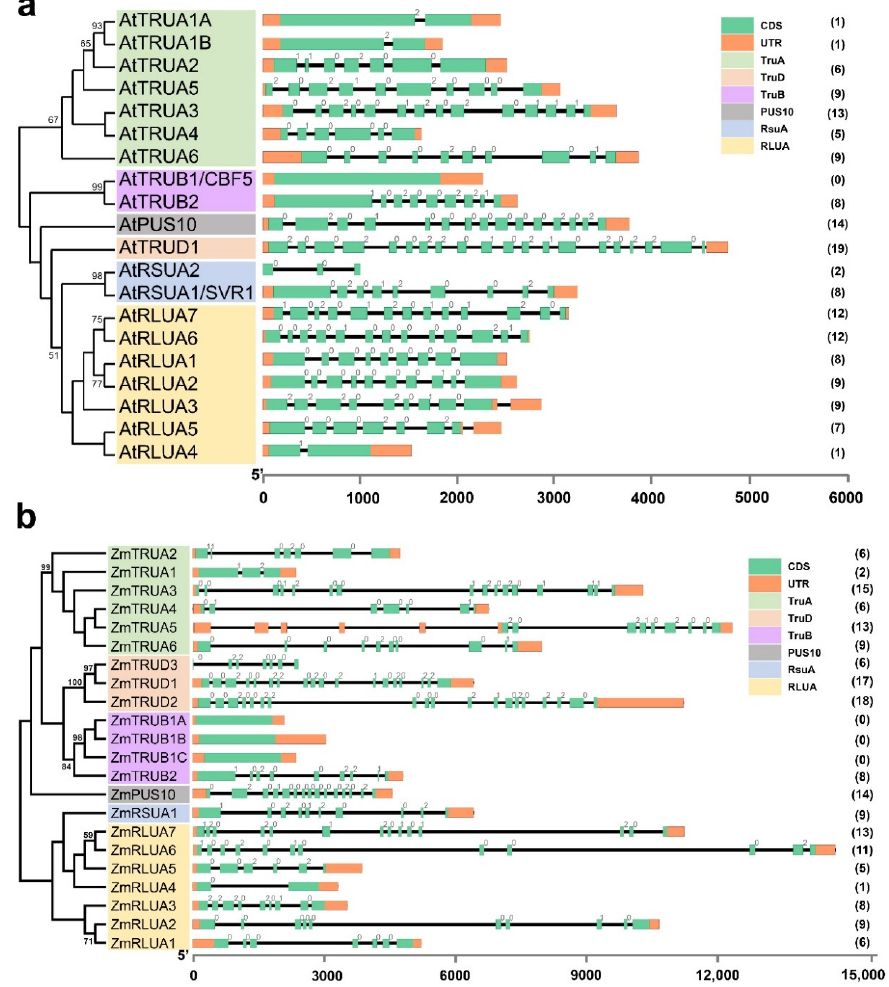
Figure 3. Exon-intron structures and intron phases of AtPUS and ZmPUS genes. ( a ) Exon-intron structures and intron phases of AtPUS genes. ( b ) Exon-intron structures and intron phases of ZmPUS genes. The green box, orange box, and black line indicate exon, UTR, and intron, respectively. The PUS members in the branches of phylogenetic tree covered by a colored panel belong to the same PUS subfamily as indicated. The numbers in brackets are the numbers of intron of the corresponding AtPUS and ZmPUS genes. The phases of intron (0, 1, and 2) are shown on the left top of the corresponding